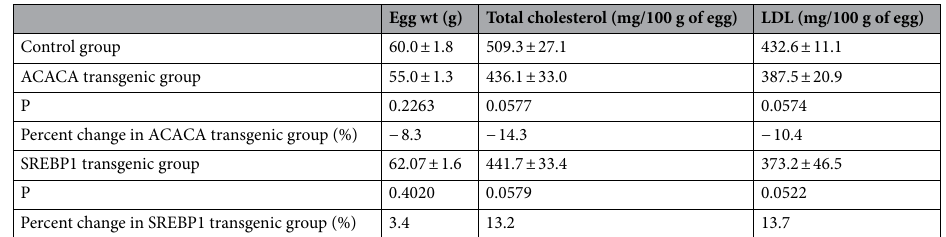
Table 9. Egg cholesterol content (Mean ± standard deviation) in transgenic (n = 2 for ACACA transgenic group and n = 2 for SREBP1 transgenic group) and control broiler birds (n = 2) at 52 weeks of age during 1st generation. The total cholesterol and LDL content in eggs were measured in knock down and control groups.